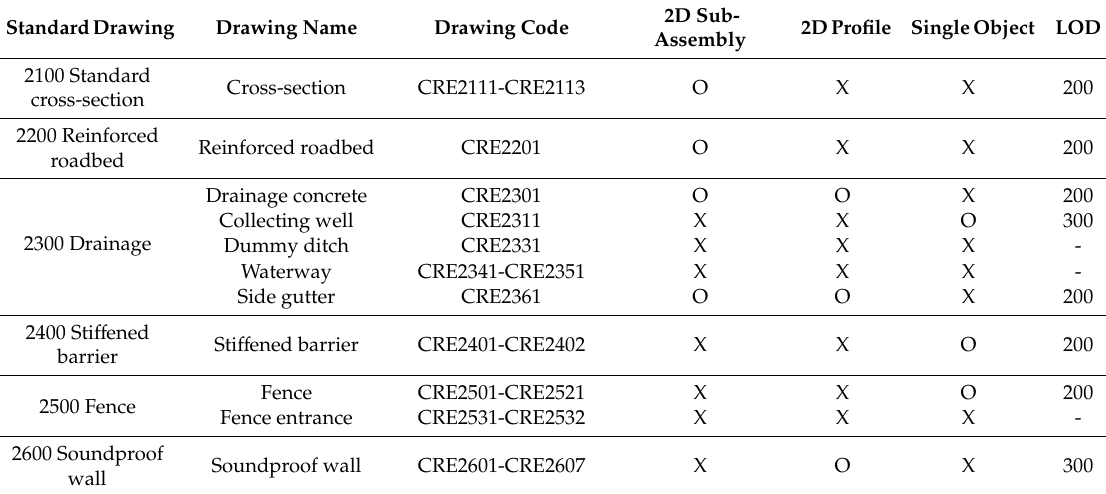
Table 2. Library types and earthwork